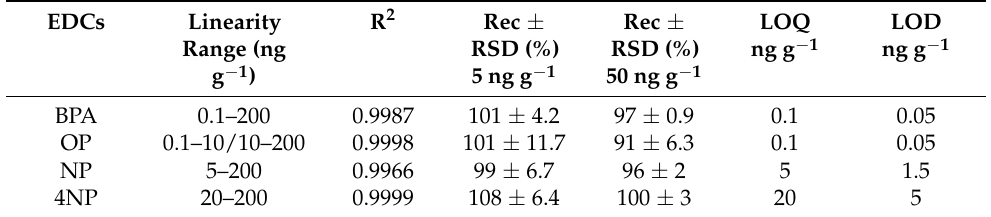
Table 1. QuEChERS-based analytical method performance in milk samples fortified with the target EDCs at two concentration